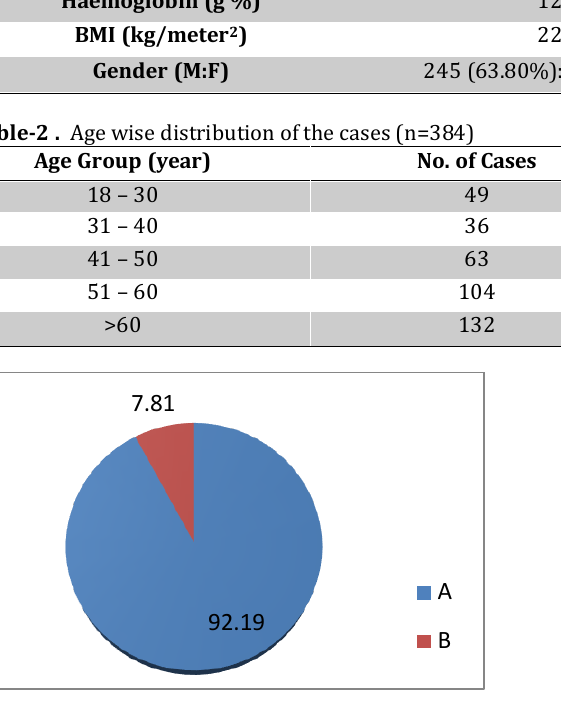
Figure 1 . Prevalence of iatrogenic Cushing syndrome in obstructive airway disease A= Obstructive airway disease with Iatrogenic Cushing syndrome. B= Obstructive airway disease without Iatrogenic Cushing syndrome.